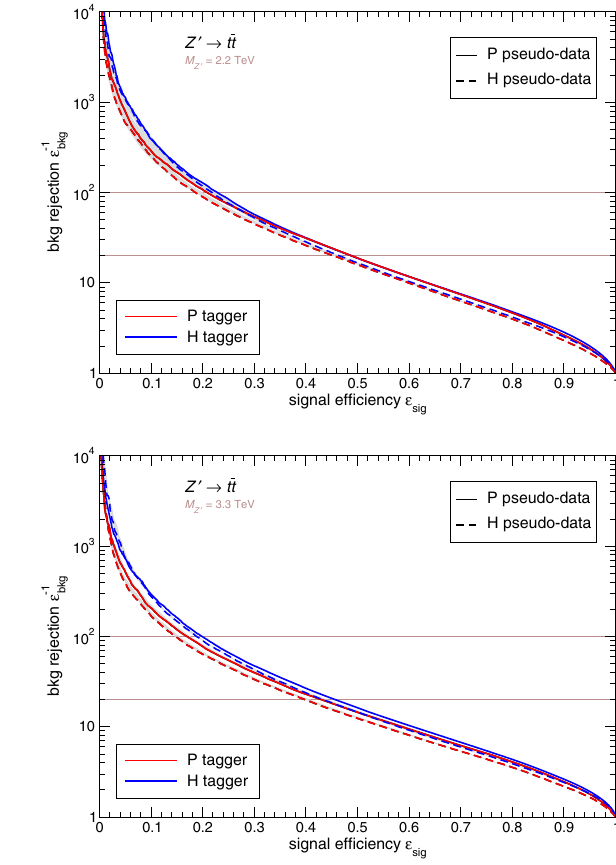
Fig. 5 ROC curves for 3P top jets